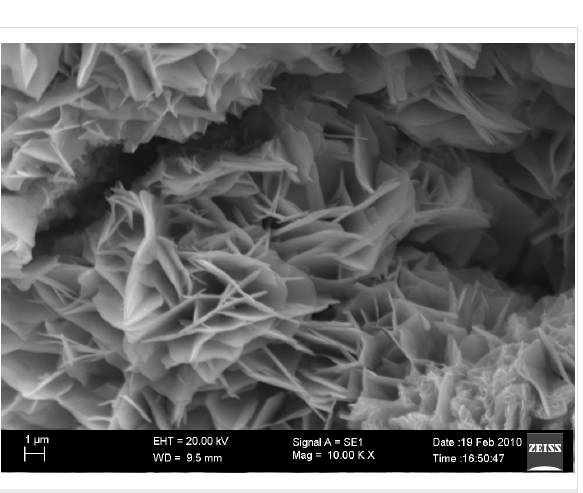
Scheme 2: Synthesis of dendritic macromolecule G 6 .